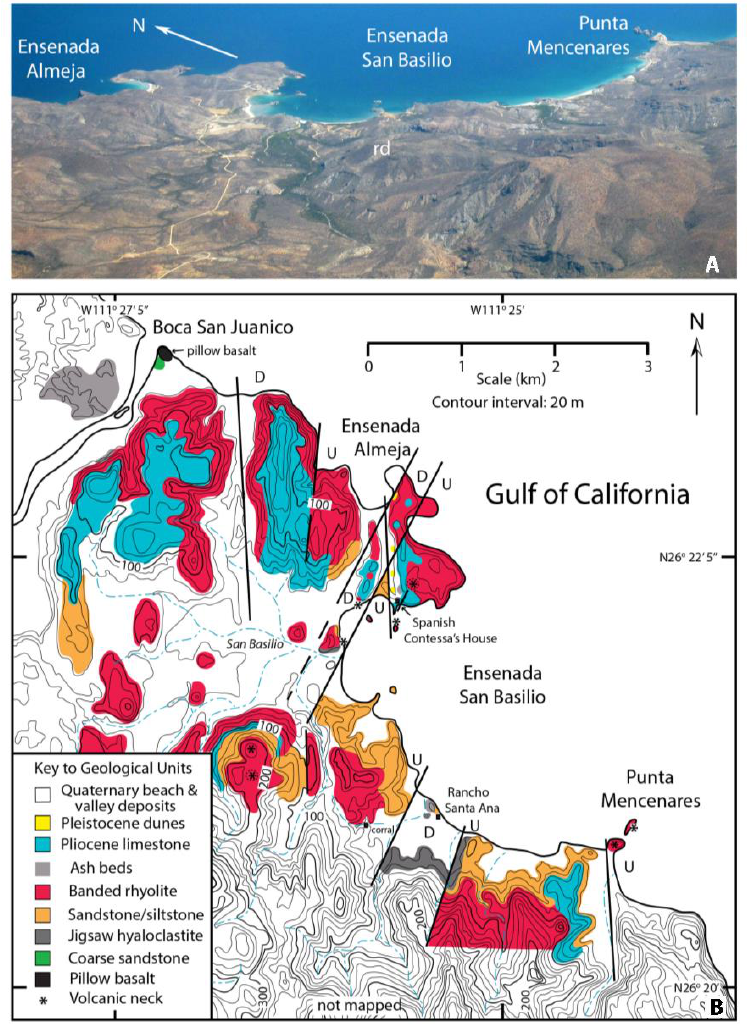
Figure 2. San Basilio topography: ( A ) Aerial photo covering 25-km 2 between Punta Mencenares and Ensenada Almeja, rd = rhyolite dome, ( B ) Geologic map.